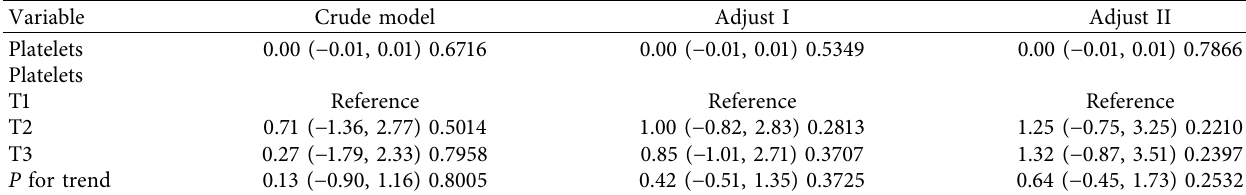
Figure 1: Association between platelets and cognitive function of atrial fibrillation. A threshold and a nonlinear relationship between platelet count and the MoCA score were found in a generalized additive model. The solid red line represents the smooth curve fit between variables. Blue bands represent the 95% confidence interval from the fit. Models were adjusted for age; sex; BMI; educational level; smoking; alcohol consumption; valvular disease; hypertension; diabetes mellitus; heart failure; coronary artery disease; myocardial infarction; hyperlipidemia; cerebral infarction history; aspirin; warfarin; clopidogrel; rivashaban; type of AF; duration of AF; Hb; RBC; PT; INR; APTT; D-dimer; FT3; FT4; TSH; creatinine; urea; UA; AST; ALT; lipoprotein; TC; TG; HDL; LDL; and LVEF. Table 3: Relationship between platelet count and cognitive function in different models.